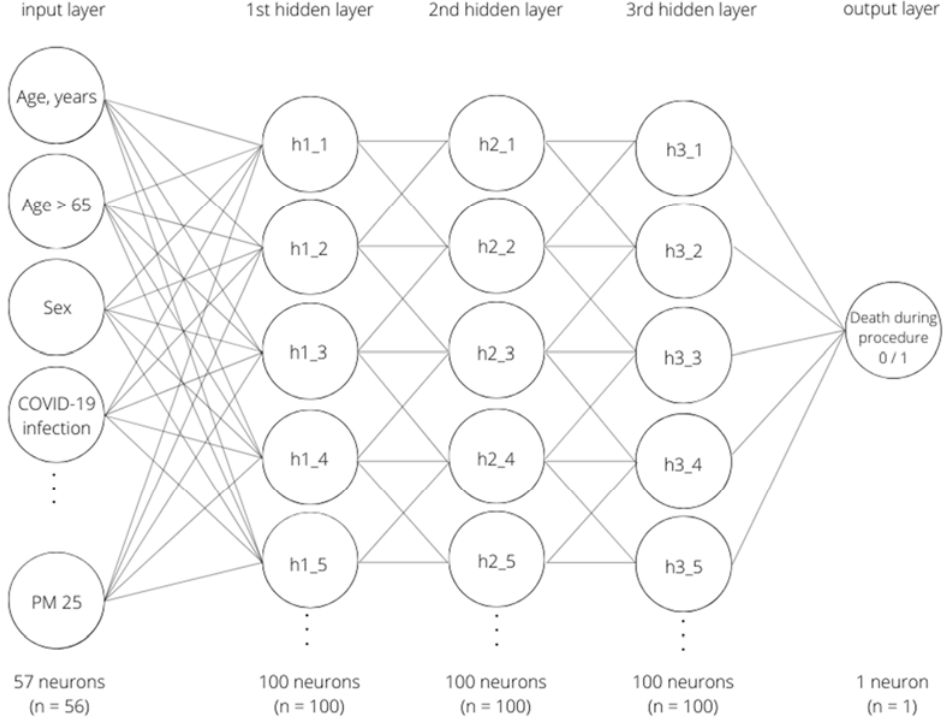
Figure 2. Model of the neural network.